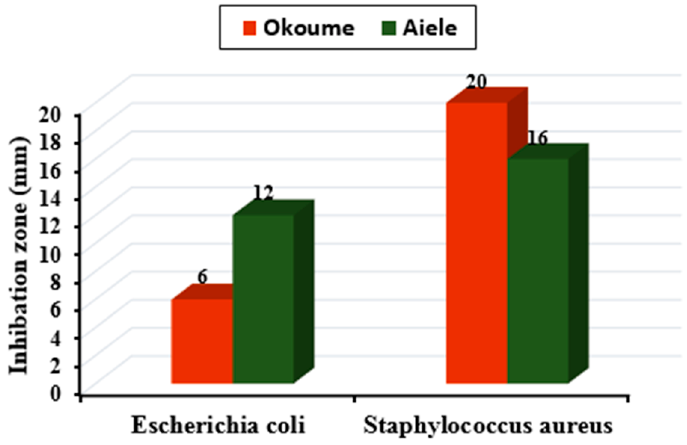
Figure 4. Antimicrobial effects of okoume and aiele essential oils on two pathogenic